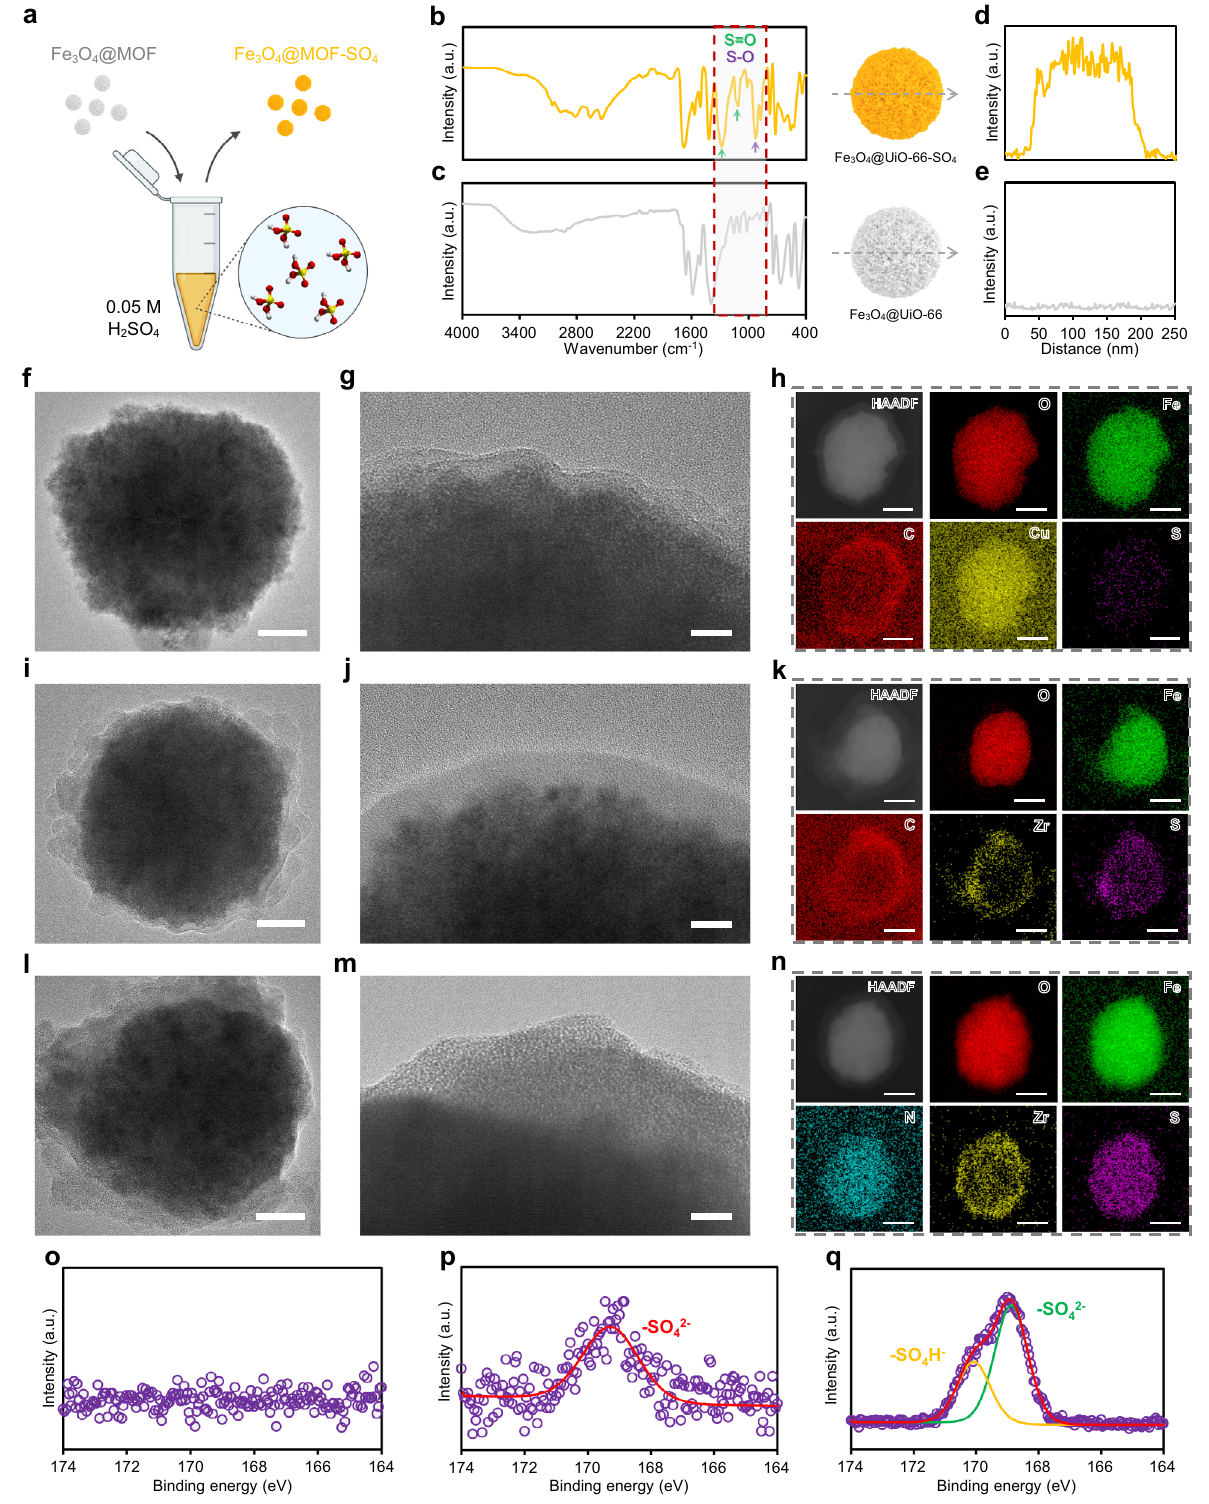
Fig. 4 Coordination of chelating sulfate species in defected core – shell structure. a Schematic illustration of the preparation of water-dispersible Fe 3 O 4 @MOF – SO 4 nanocatalyst via aqueous sulfation process. b , c FTIR spectra, and d , e sulfur line scanning pro fi le of Fe 3 O 4 @UiO-66 and Fe 3 O 4 @UiO- 66-SO 4 . TEM, HAADF, and EDX images of f – h Fe 3 O 4 @HKUST-SO 4 , i – k Fe 3 O 4 @UiO-66-SO 4 , and l – n Fe 3 O 4 @UiO-66-NH 2 – SO 4 . Scale bars are 50 ( f , i , l ), 10 ( g , j , m ), and 100 nm ( h , k , n ). High-resolution XPS spectra of sulfur species in o Fe 3 O 4 @HKUST-SO 4 , p Fe 3 O 4 @UiO-66-SO 4 , and q Fe 3 O 4 @UiO-66- NH 2 -SO 4